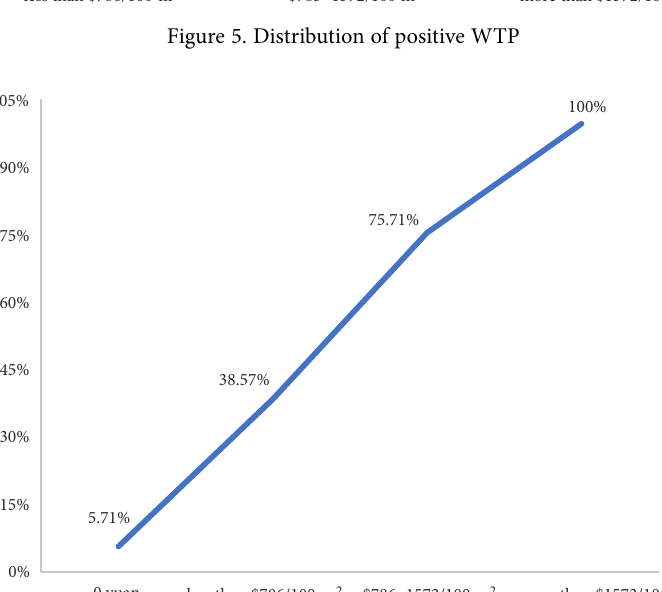
Figure 6. Cumulative frequency distribution of non-negative